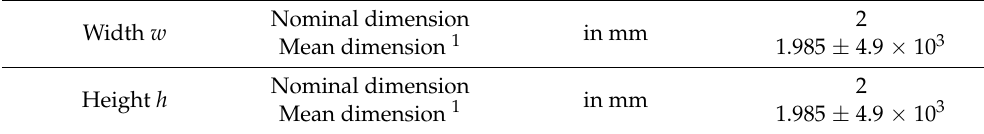
Table 1. Dimensions of feather keys used as electrical contact pins according to DIN